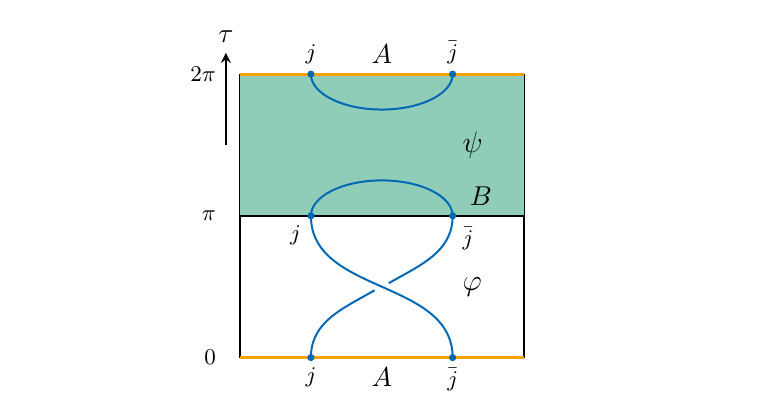
Figure 13 . The path integral representation of the transition matrix τ ψ | ϕ